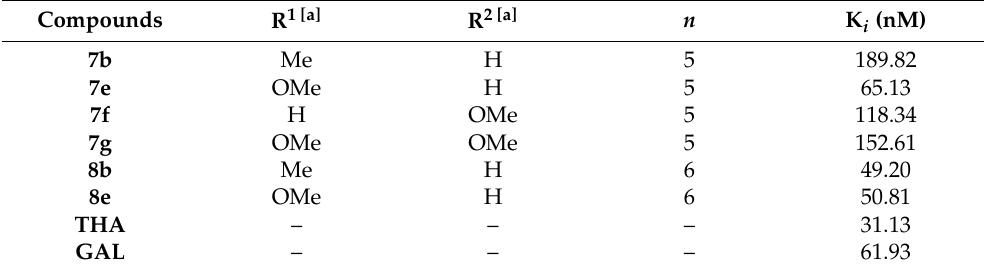
Figure 4. Kinetic parameters (K i ) of AChE inhibition by two high-activity Coumarin–BMT hybrids ( 8b and 8e ) and positive control THA and GAL. Lineweaver-Burk reciprocal plots of the AChE initial velocity at substrate concentrations (5 mM and 10 mM) in the presence of ( a ) THA, ( b ) GAL, ( c ) 8b and ( d ) 8e. Table 2. Inhibition constants (K i ) of the target compounds against human